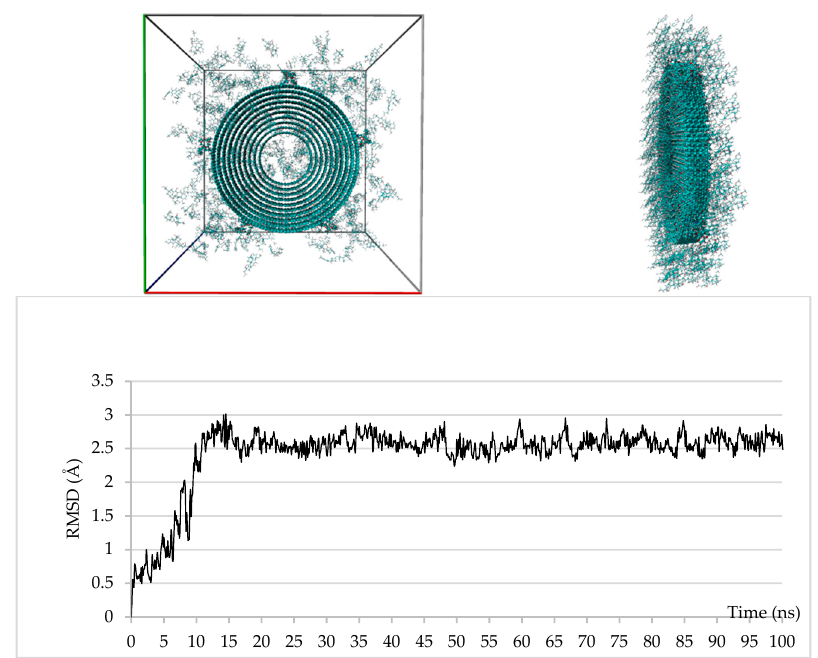
Figure 15. Upper: SSy4 at the start (left) and the end (right) of the MD simulation; bottom: plot of the RMSD of the DOX molecules during the 100 ns of the MD